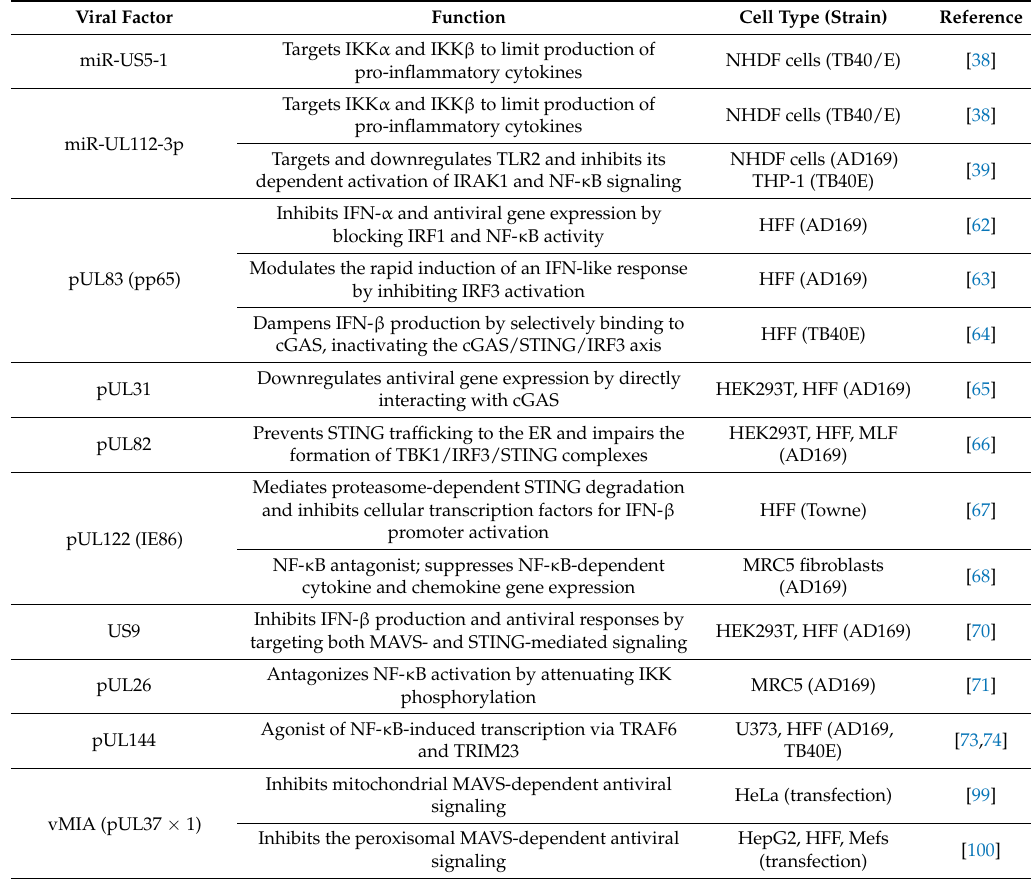
Inhibits the peroxisomal MAVS-dependent antiviral signaling cGAS: cyclic guanosine monophosphate–adenosine monophosphate synthase; ER: endoplasmic reticulum; IFN: interferon; IKK: NF- κ B inhibitor (I κ B α ) kinase; IRAK: interleukin-1 receptor-associated kinase; IRF: IFN regulatory factor; MAVS: mitochondrial antiviral-signaling protein; NF- κ B (nuclear factor kappa B); STING: stimulator of IFN genes; TBK1: TRAF family member-associated NF- κ B activator (TANK)-binding kinase protein 1; TLR: Tool-like receptor; TRAF: tumor necrosis factor (TNF) receptor-associated factor; TRIM: Toll/interleukin receptor (TIR)-domain-containing adapter-inducing IFN- β